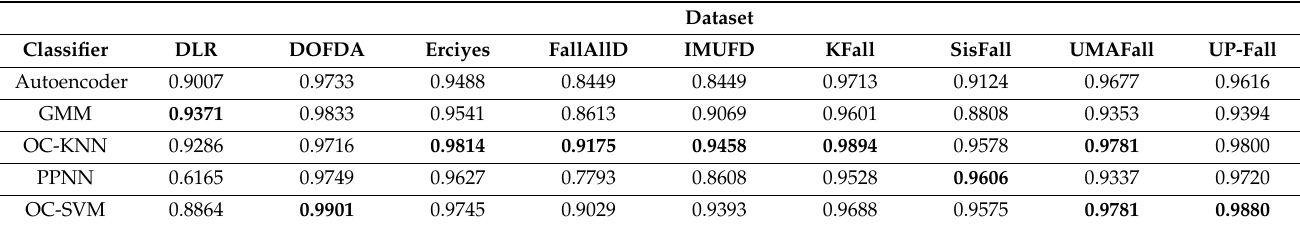
Table 8. Maximum obtained geometric mean of sensitivity and specificity ( rameters of the